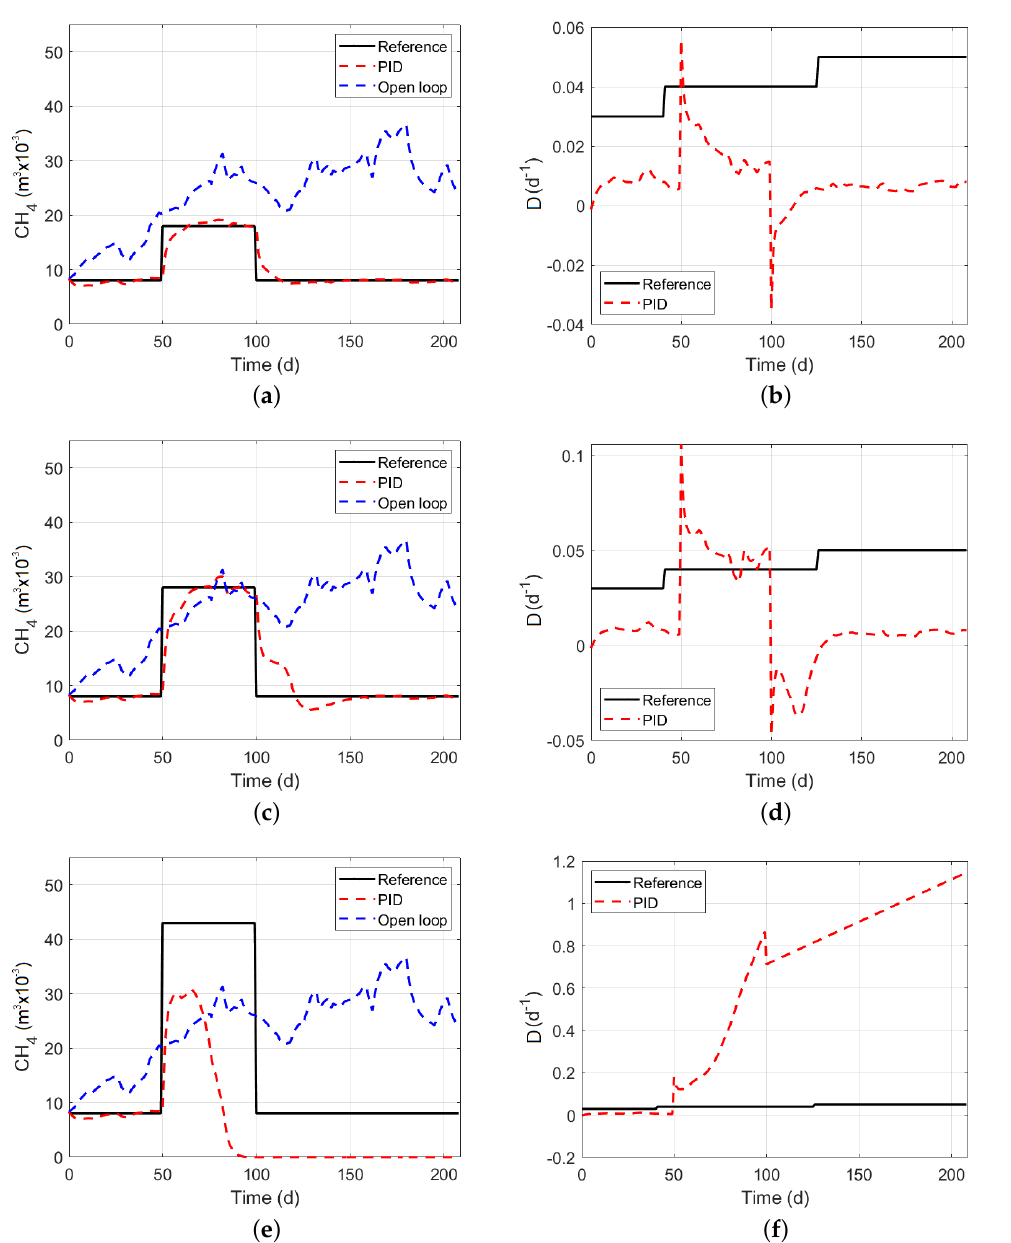
Figure 5. Performance of PID control after step changes. ( a ) Low change in CH 4 ; ( b ) D values after a low change in CH 4 ; ( c ) medium change in CH 4 ; ( d ) D values after a medium change in CH 4 ; ( e ) high change in CH 4 ; ( f ) D values after a high change in CH 4